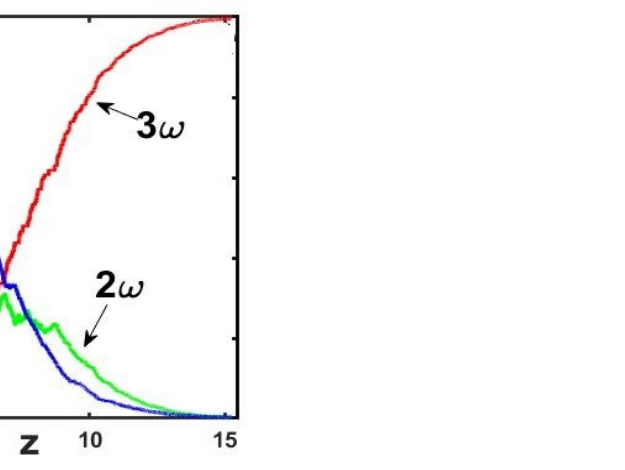
Figure 3. Same as in Figure 2 when the QPM lattice has (see, e.g., Figure 1b) equally sized domains in each segment.